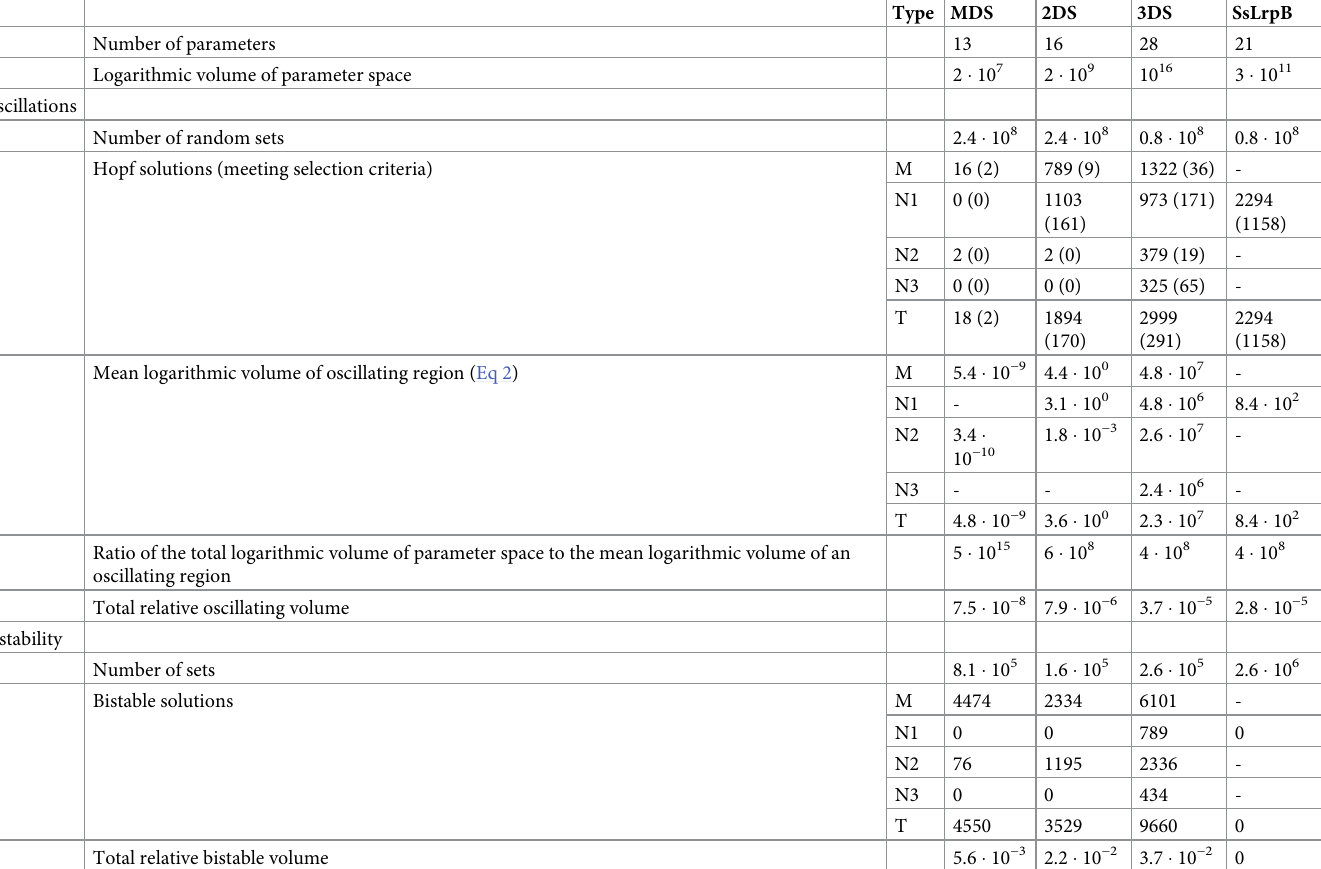
Table 2. Summary of the search for oscillations and the scan for